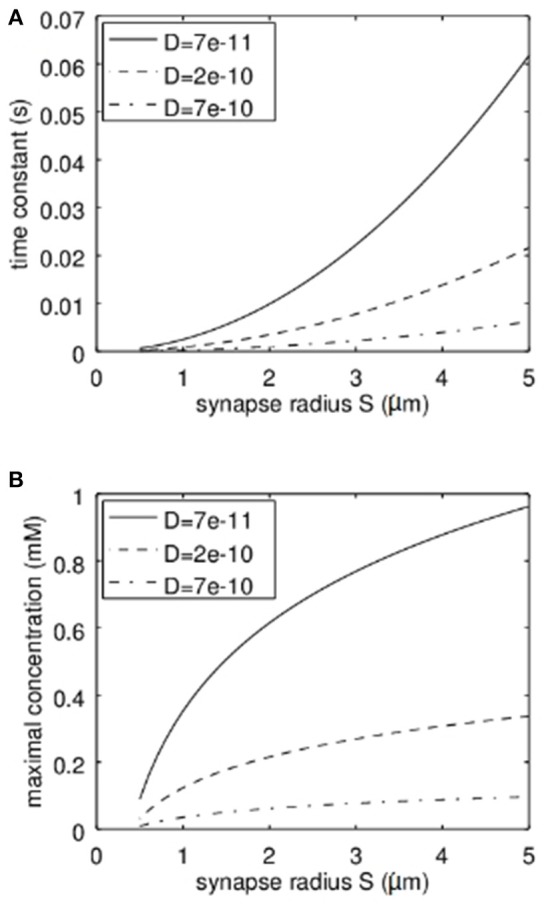
Dependence of the time constant of Zn2+-changes and the maximum concentration of Zn2+ in dependence on the synapse radius S and the effective diffusion coefficient. (A) Here the quadratic increase of the time constant can be seen. The dependence on the diffusion coefficient is linear. (B) Here the logarithmic dependence of the maximal concentration on the synapse radius S can be recognized while also here the dependence on the diffusion coefficient is linear.